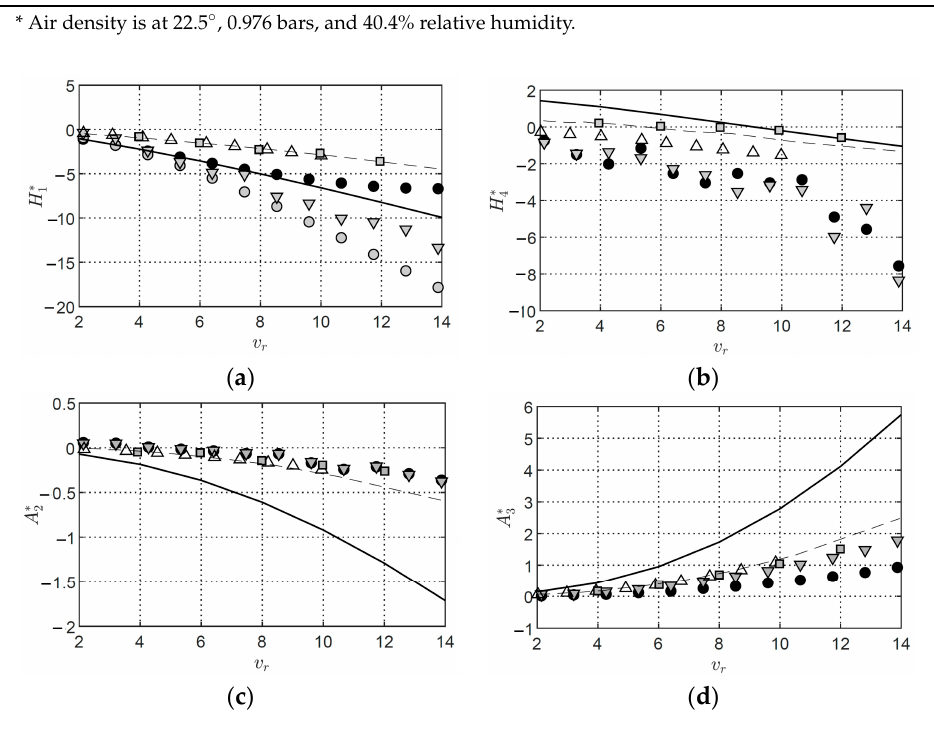
Figure 23. Aerodynamics derivatives of Great Belt section: ( • ) polynomial fit of exponential decay curve, ( (cid:72) ) Hilbert transform method, ( • ) polynomial fit of logarithmic decrement method, ( (cid:4) ) wind tunnel test [42], ( ∆ ) wind tunnel test [2], ( − − ) water channel tests, ( — ) flat plate by Theodorsen. ( a ) H ∗ ; ( b ) H ∗ ; ( c ) A ∗ ; ( d ) A ∗ 2 3 1 4